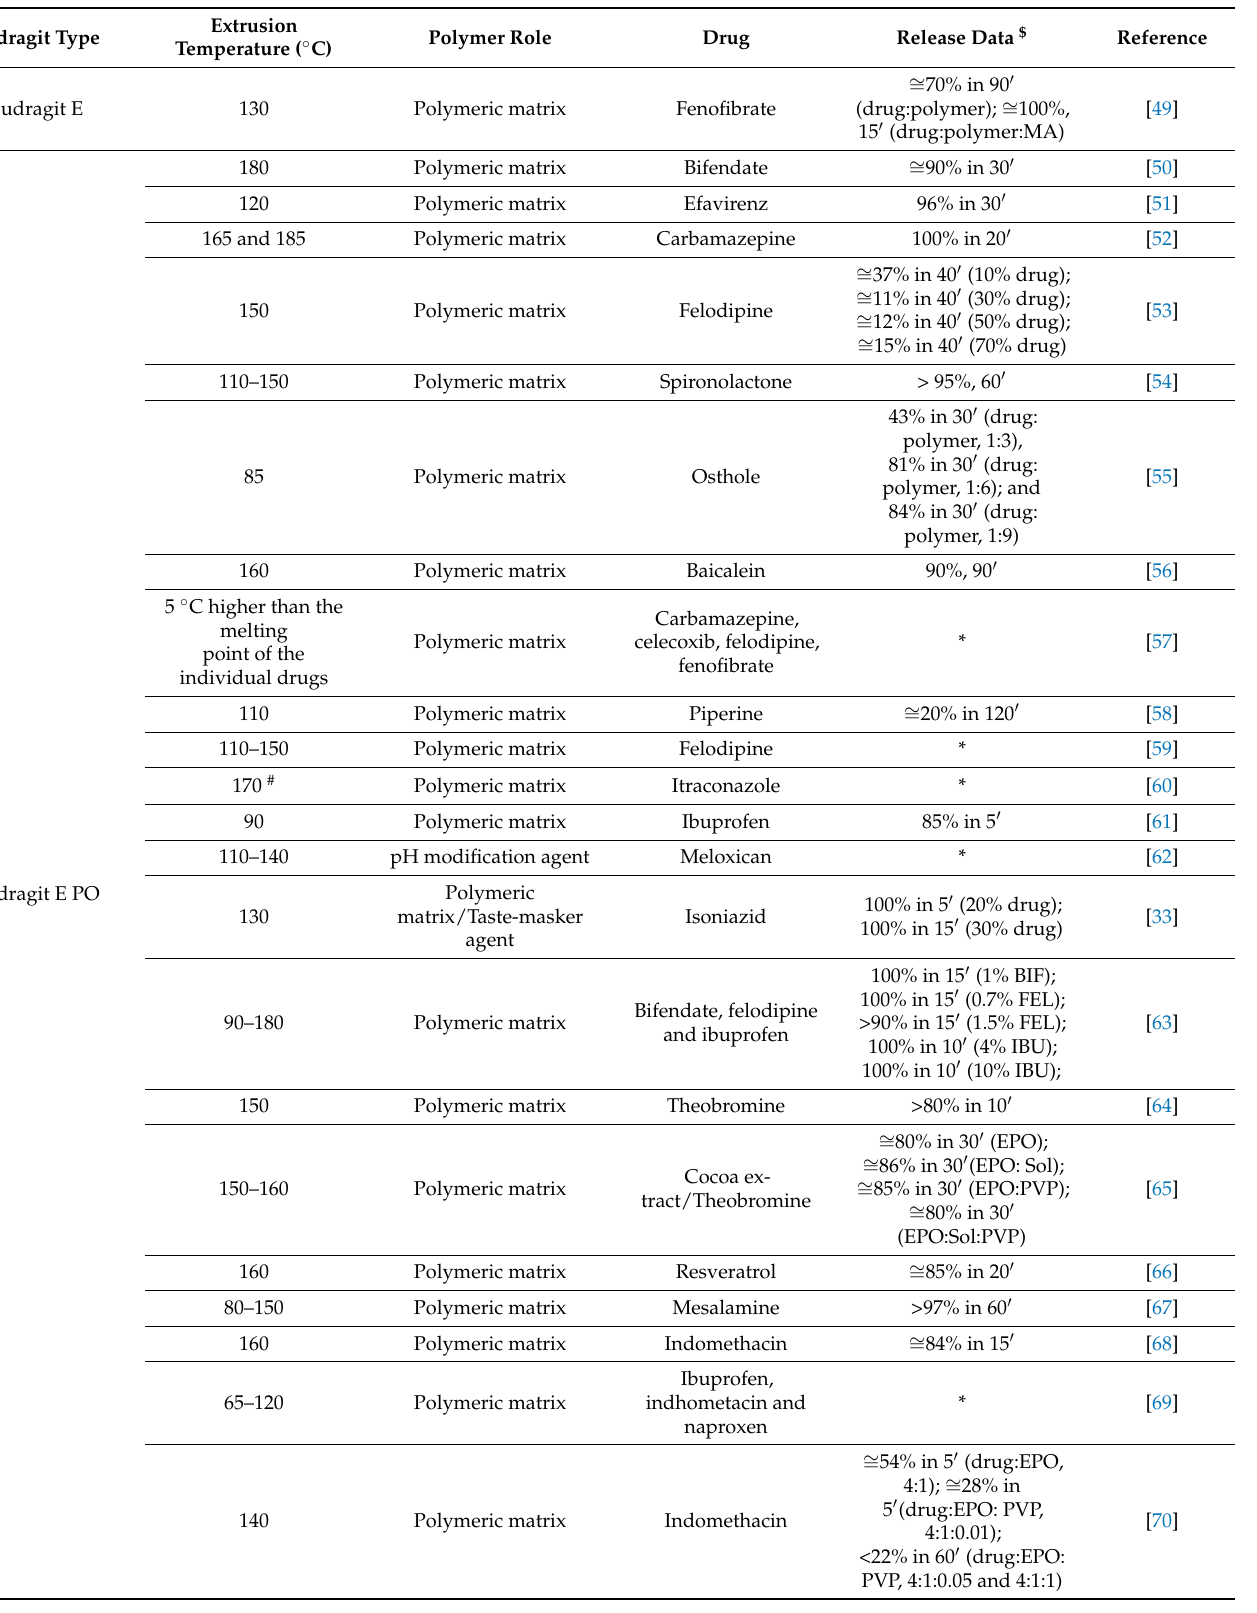
Table 2. Solid dispersions produced by HME using Eudragit